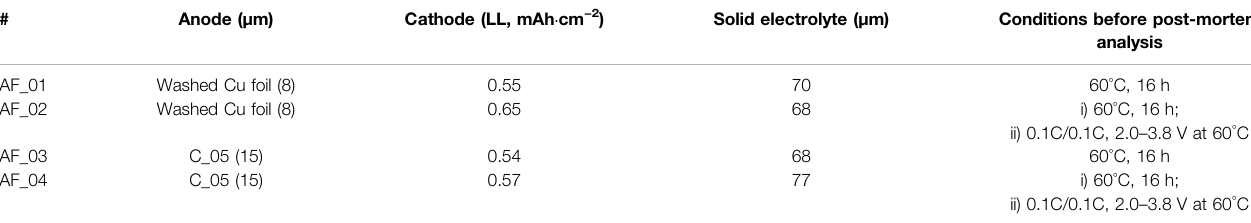
TABLE 3 | Post-mortem characterization of pouch